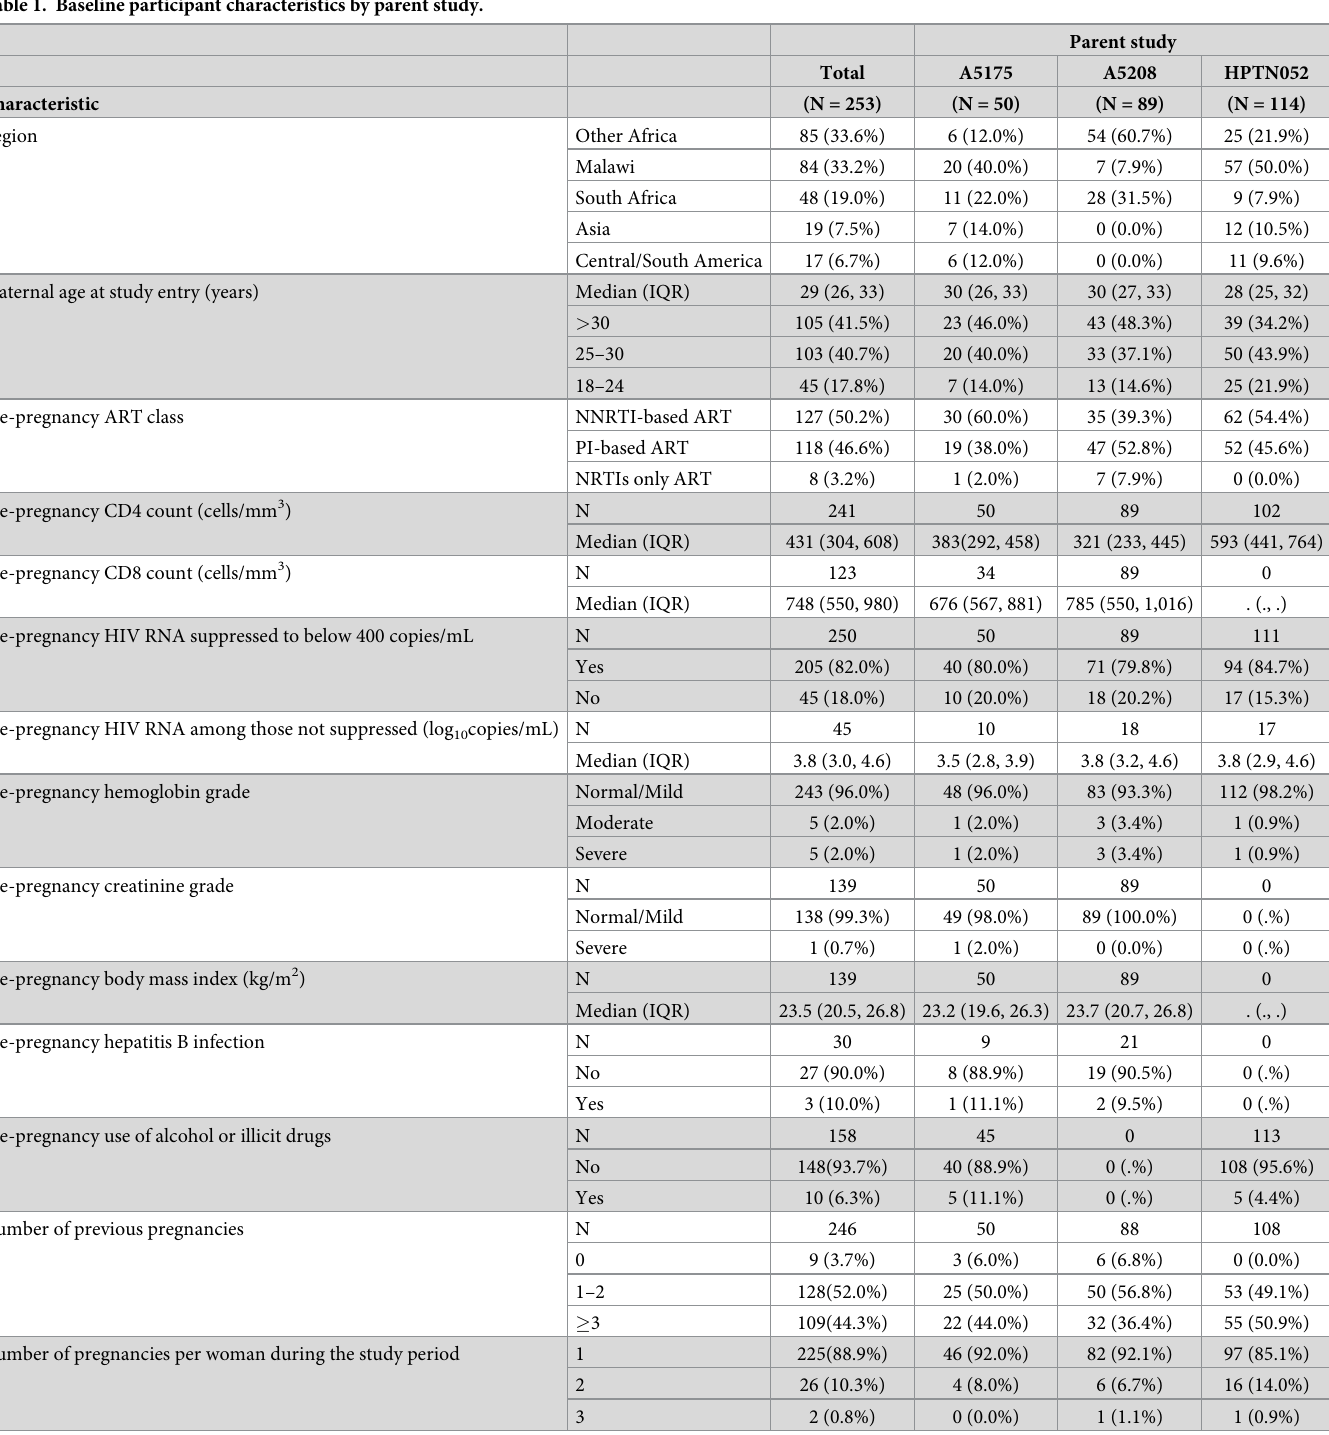
Table 1. Baseline participant characteristics by parent